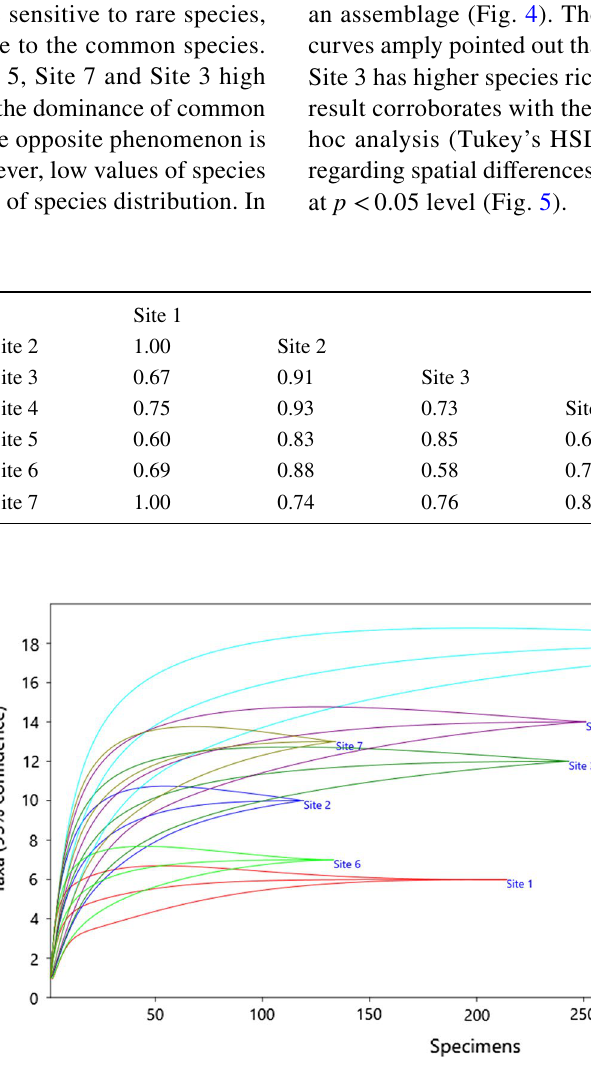
) and D SIPM values e